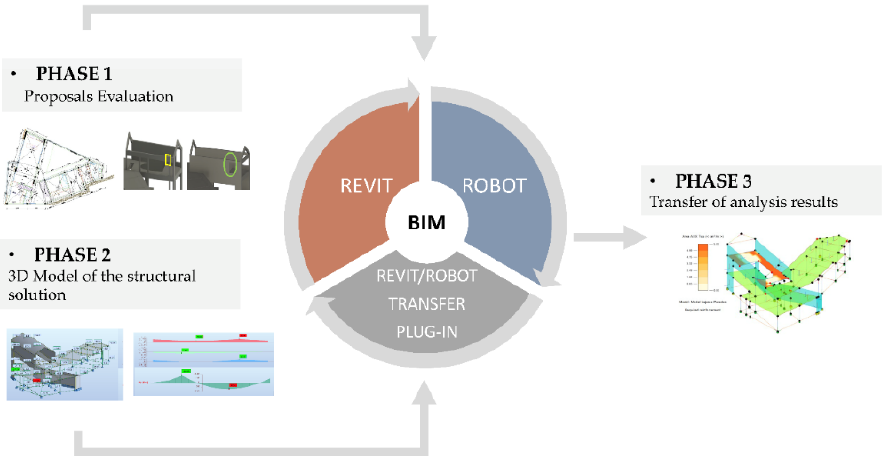
Figure 1. Phases and tools applied in the study.